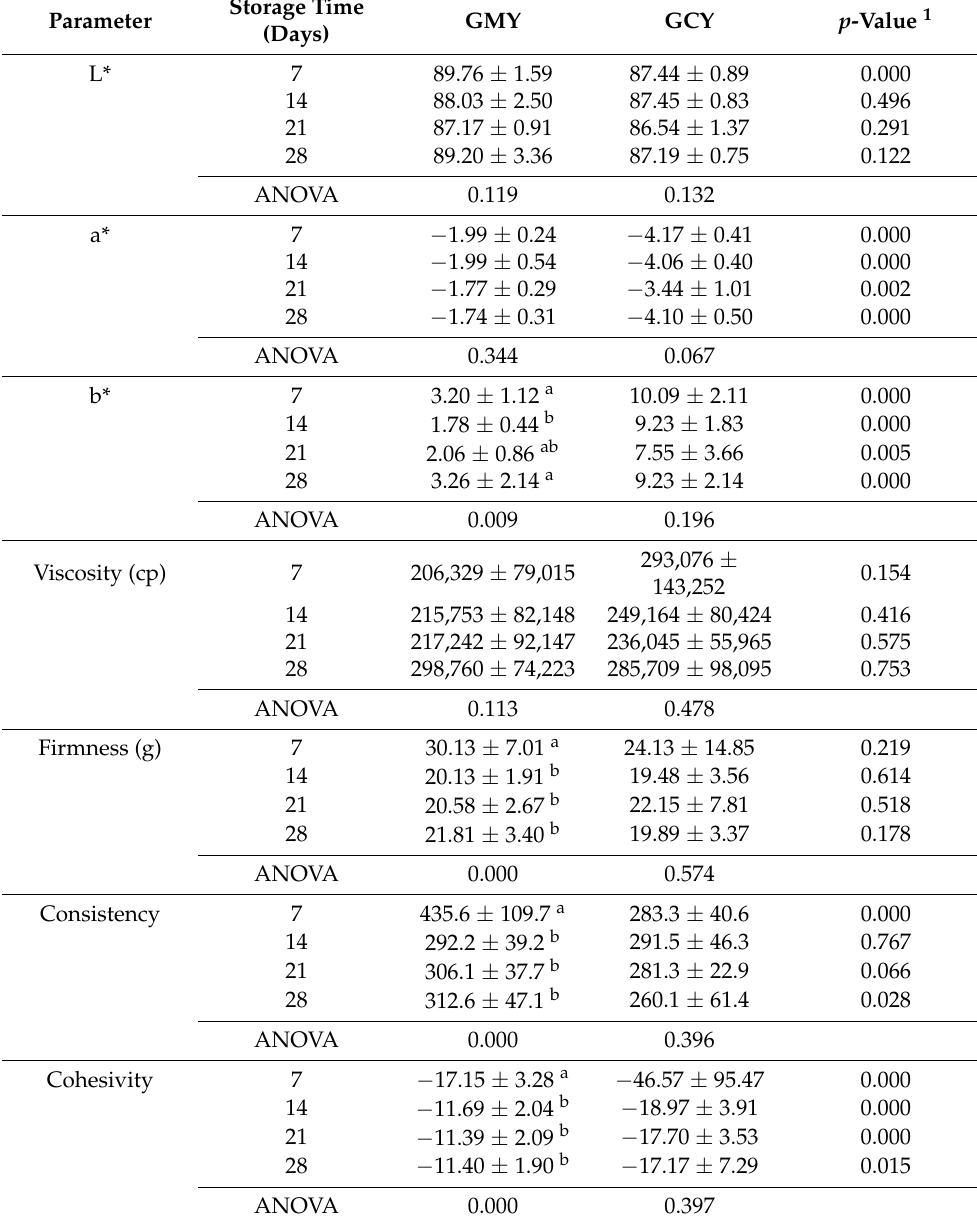
Table 4. Mean values ± standard deviation for the color (CIE L*a*b*), viscosity, and texture of